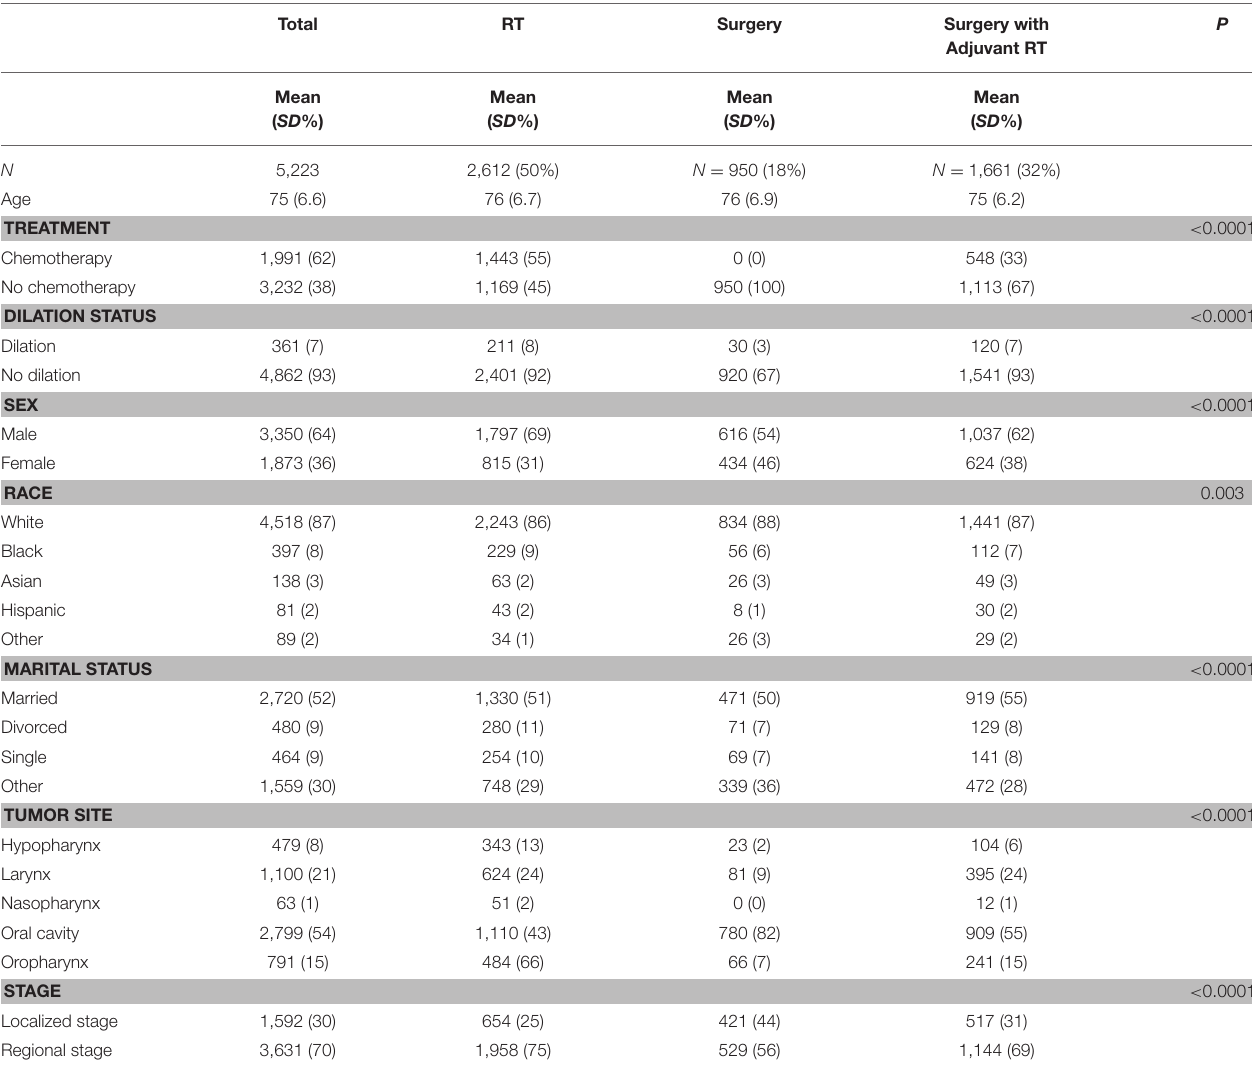
TABLE 1 | Sample descriptive